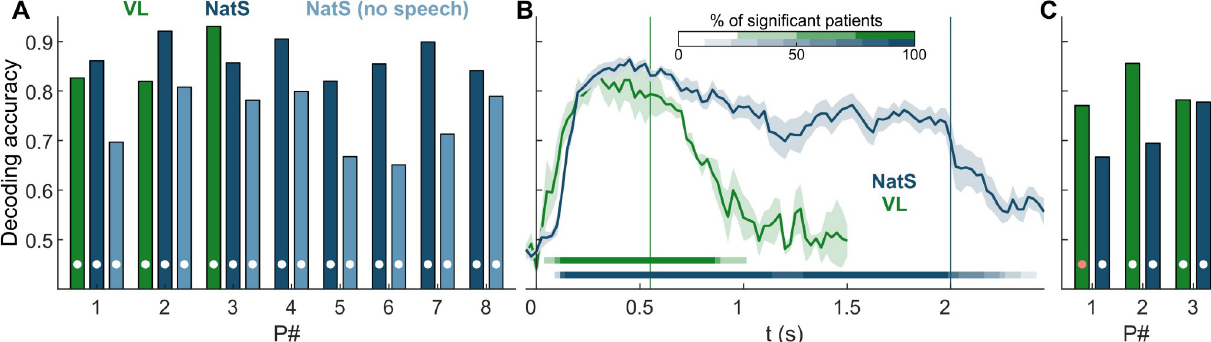
Fig 2. Decoding accuracy results. (A) Full model (i.e., all channels and time windows) decoding accuracy of vocal versus nonvocal for each patient. Dark and light blue bars correspond to NatS results with speech stimuli included or excluded, respectively (e.g., light blue is nonspeech human vocalizations versus nonvocal auditory stimuli). White dots represent statistical significance ( p < 0.01, Bonferroni corrected, permutation tests). (B) Sliding window results. Vertical lines represent stimulus offset for the 2 tasks, with horizontal lines showing fraction of patients with statistically significant decoding in that window ( p < 0.001, FDR corrected, cluster-based permutation tests). (C) Cross-task decoding accuracy, with color indicating the training set (white: p < 0.01, red: p < 0.05, Bonferroni corrected, permutation tests). Associated data are located on Zenodo in the Fig 2 folder (doi: 10.5281/zenodo.6544488). FDR, false discovery rate; NatS, Natural Sounds; VL, Voice